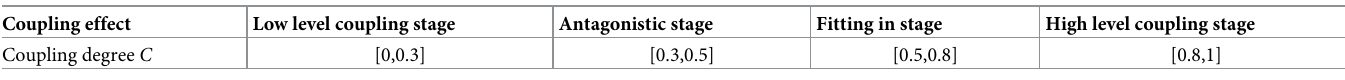
Table 2. Coupling stages and judgment criteria.